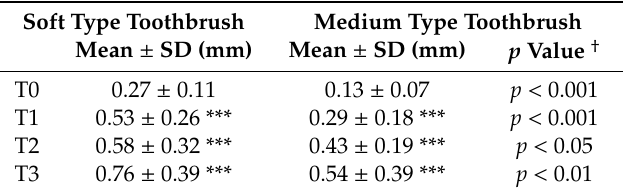
Table 2. Changes in wear index of soft and medium